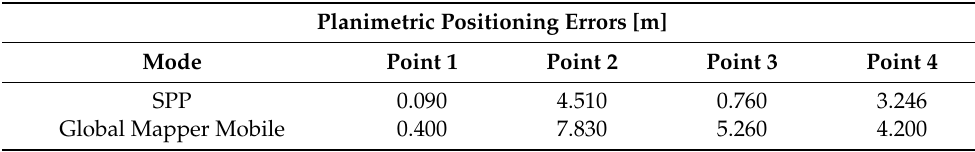
Figure 6. Test area: ( a ) Orthophoto with indication of the vertexes surveyed; ( b ) points surveyed with SPP and Global Mapper Mobile. Table 13. Planimetric positioning errors achieved on the area